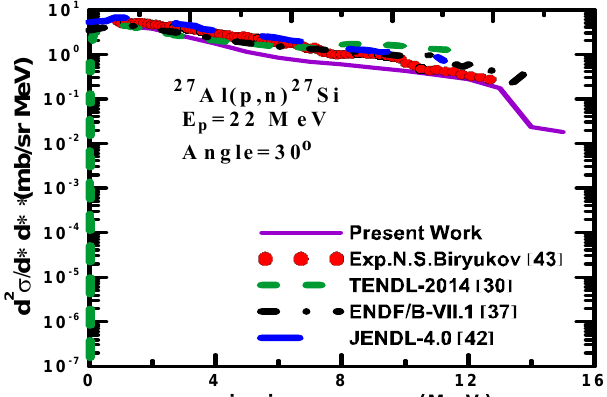
Fig. 11: The double differential cross sections calculated in the present work as a function of emission energy and different emission angle 30 0 for the reaction 27 Al+p and emitted triton at 22 MeV compared with experimental data [43] other theoretical results (TENDL [30], ENDF/B-VI [37] and JENDL-4.0